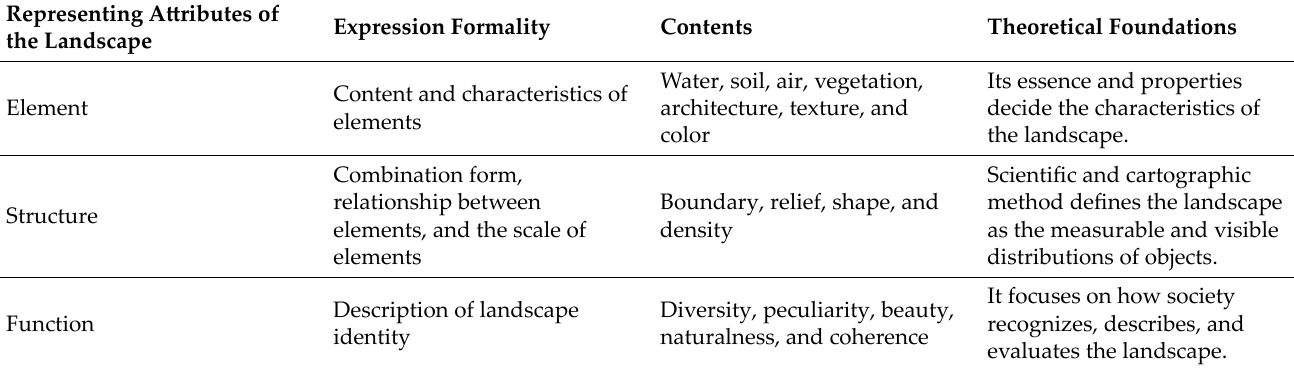
Table 1. The decomposition of landscape evaluation